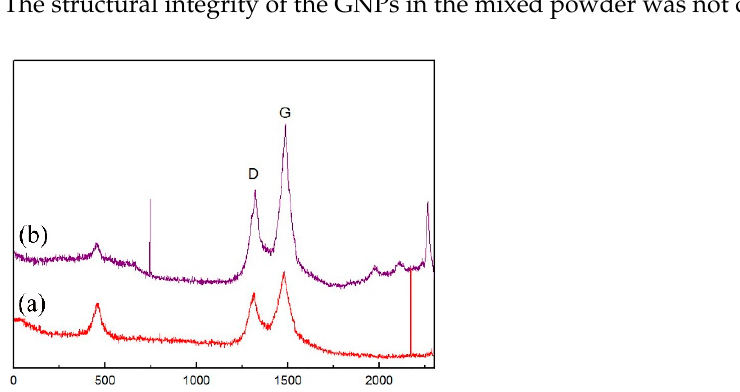
Figure 3. TEM photographs of CeO 2 -GNPs: ( a ) TEM and ( b ) HRTEM images of CeO 2 -GNPs; ( c ) SAED patterns; ( d ) cor- responding EDX result of the nanoparticles.